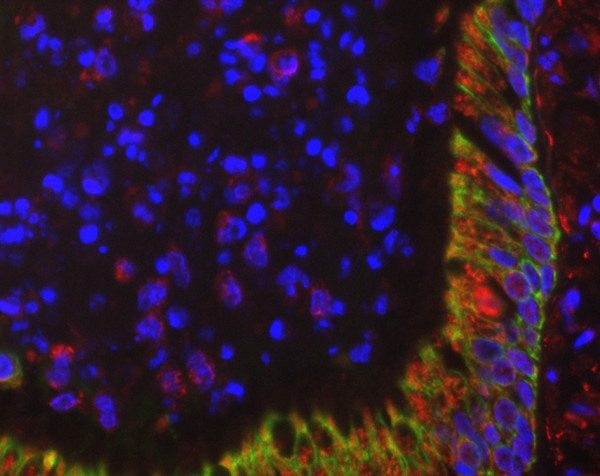
Immunofluorescence of equine lung tissue in RAO. In horses with RAO, the abundance of chlamydial inclusion bodies (red spots) in bronchiolar epithelial cells (stained green with an anti-cytokeratin pan antibody) and macrophages varies from high to low (compare Figure 7) (original magnification 40×).